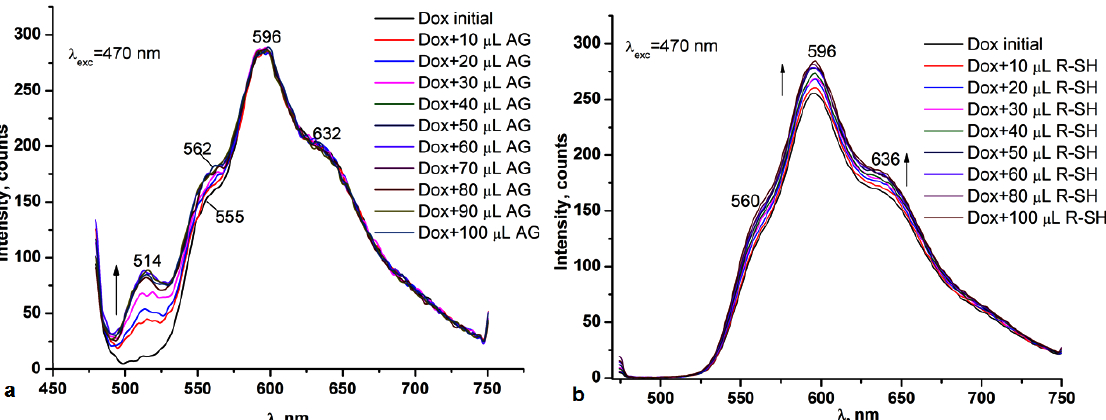
Figure 4. Fluorescence spectra of Dox (0.1%) in PBS at pH 7.4 during the addition of different amounts of glucose (AG, 0.1%) ( a ) and thiol (R-SH, 0.1%) ( b ) precursors.